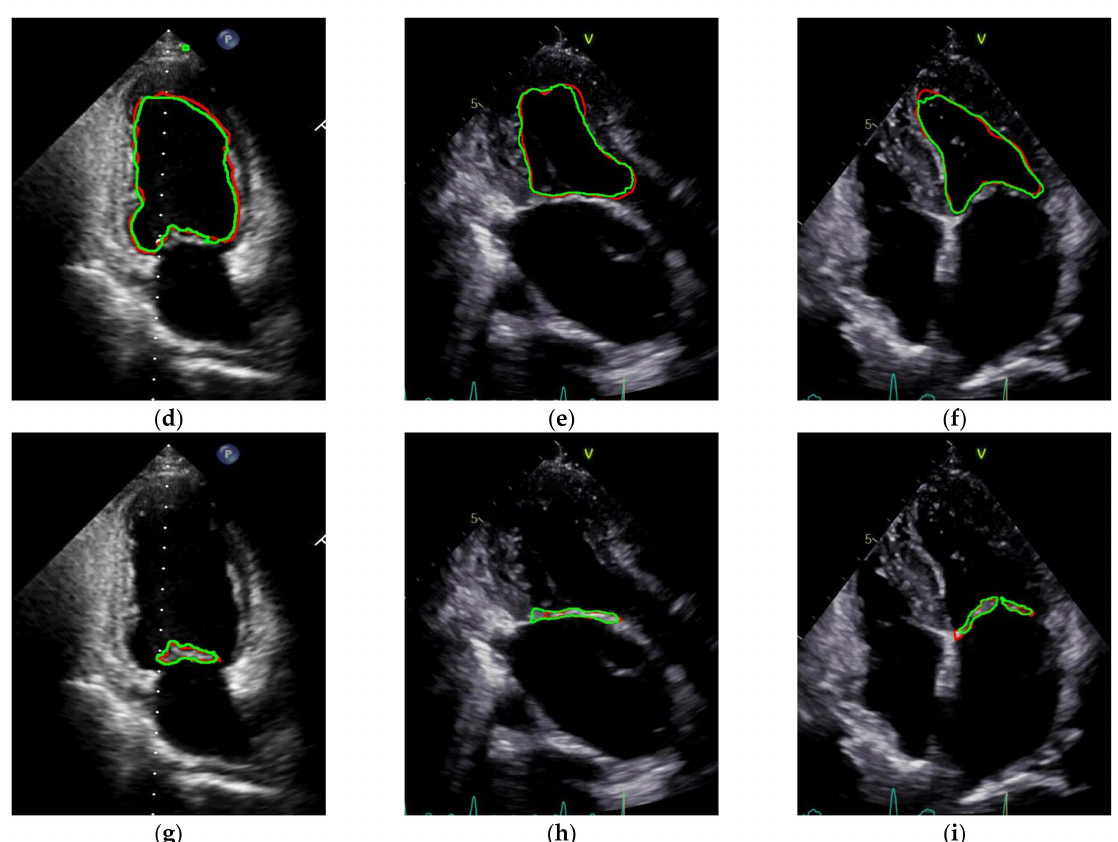
Figure 4. ( a , d , g ) Results of apical two-chamber (normal MV); ( b , e , h ) results of apical three-chamber (aFMR); ( c , f , i ) results of apical four-chamber (MV prolapse).